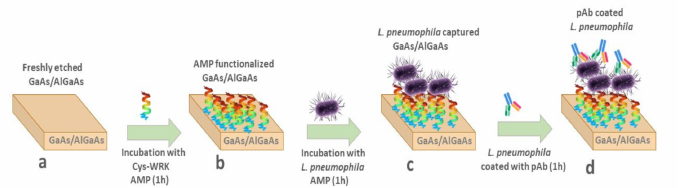
Figure 1. Schematic diagram of biosensor development, ( a ) freshly etched GaAs/AlGaAs nanoheterostructures; ( b ) adsorption of thiolated AMPs on GaAs/AlGaAs; ( c ) immobilization of bacteria on AMP-functionalized GaAs/AlGaAs; ( d ) immobilization of anti- L. pneumophila pAb on the surface of